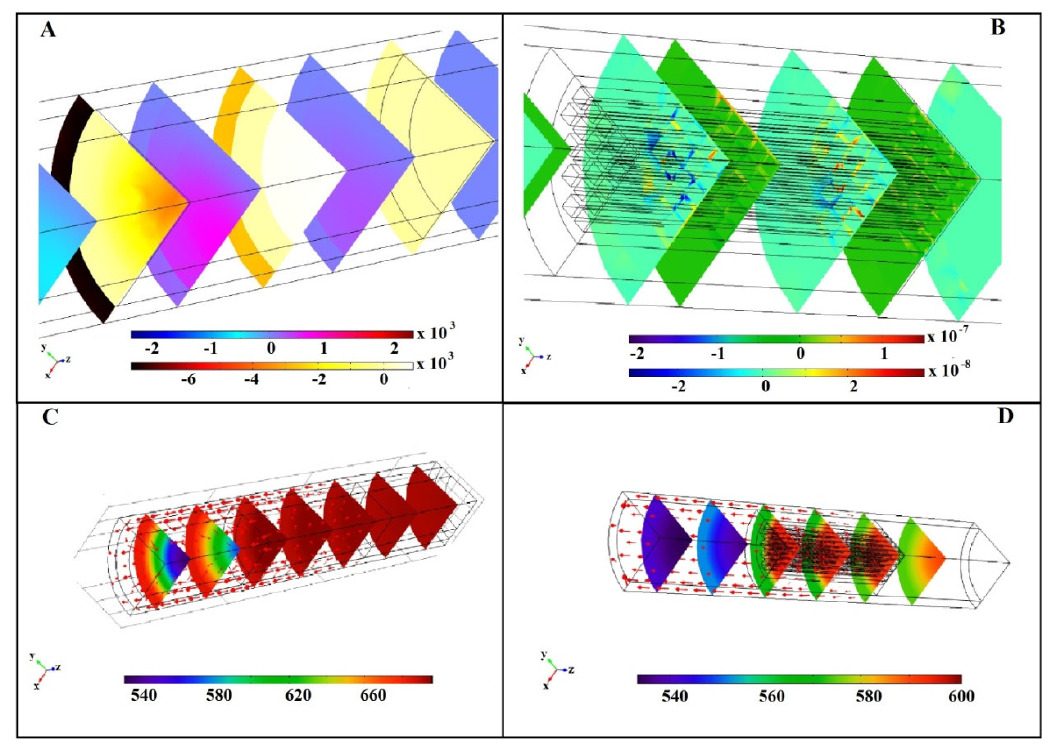
Figure 8. Temperature (K) in the 3D simulation domain: PtCeWF10 ( A , C ) and PtCeWM ( B , D ).